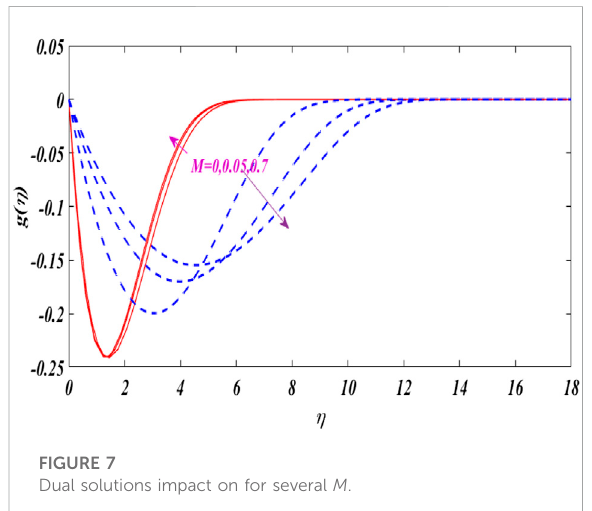
Dual solutions impact on for several M .